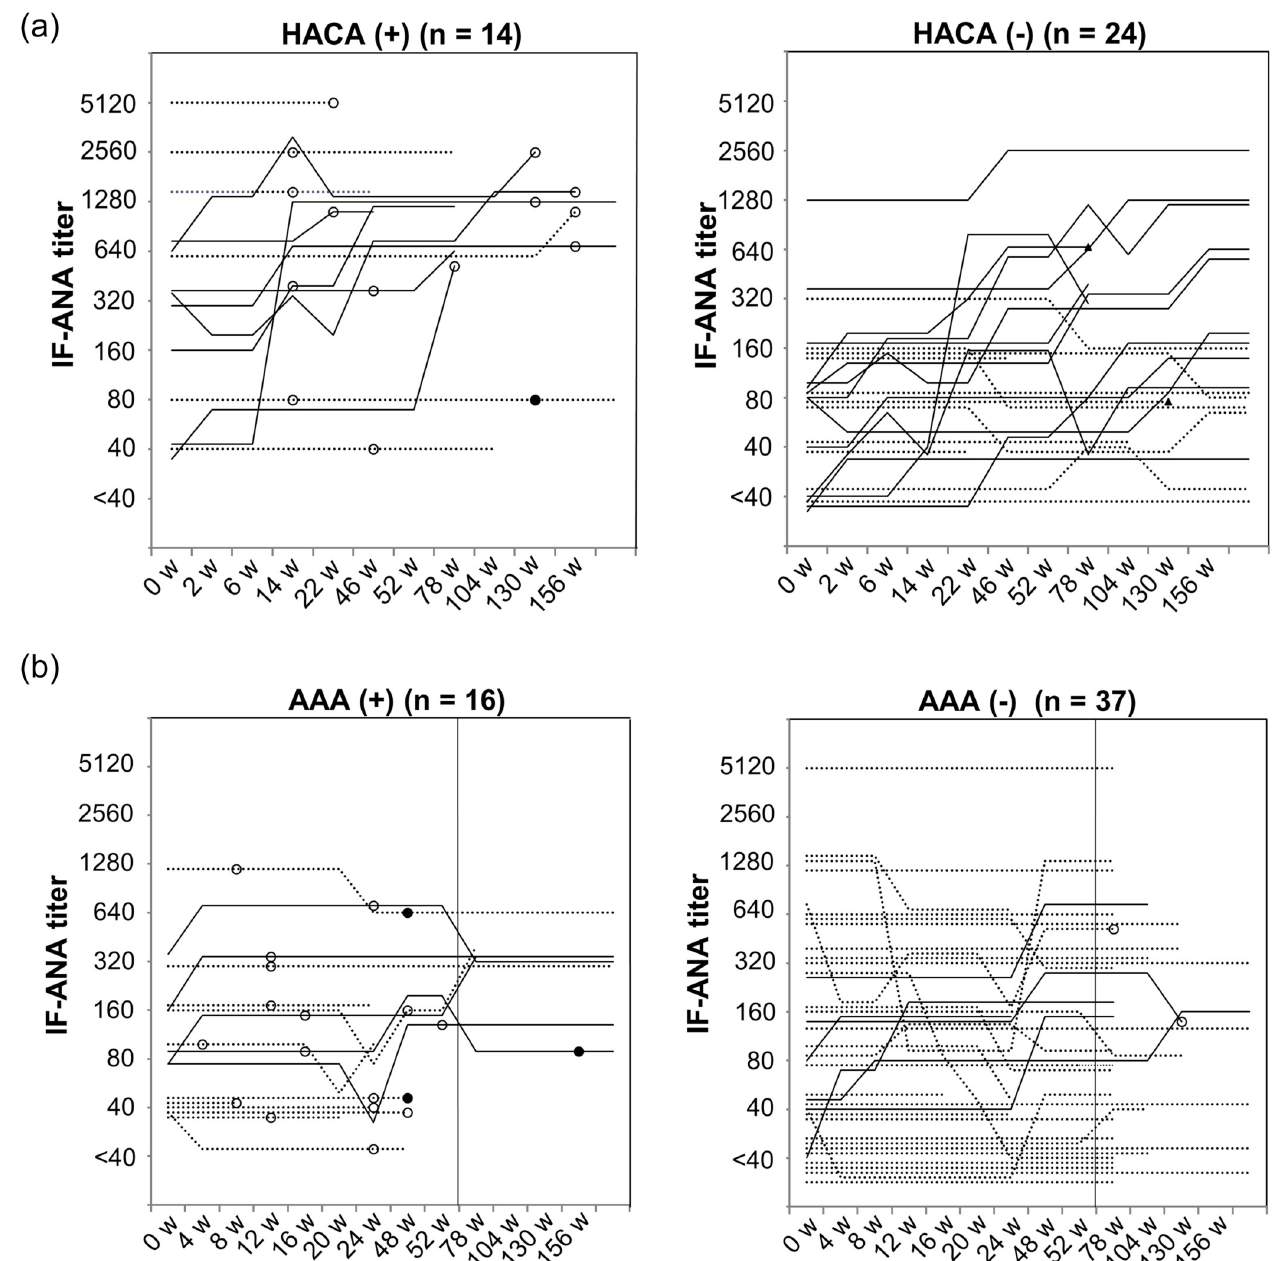
Fig 1. Change of IF-ANA titers and the presence of ADrA in patients treated with anti-TNF inhibitors. IF-ANA titers in the patients with (left) or without (right) ADrA against (a) IFX or (b) ADA are presented in the line graphs. Solid lines indicate the patients whose IF-ANA titers at the endpoint of the observation increased as compared with that of the starting point. Dashed lines indicate the patients whose titers were stable or decreased. Interruption of the graph indicates withdrawal of the anti-TNF therapy. The white circle ( � ) indicates the time when ADrA turned positive, and the black circle ( ● )indicates when ADrA turned negative again. The black triangles ( ▲ )indicate the patients who discontinued the IFX therapy due to hospital transfer or financial reasons between 53–156 weeks (w). ADrA, anti-drug antibodies; IFX, infliximab; ADA, adalimumab; HACA, anti-IFX antibodies; AAA, anti-ADA antibodies.